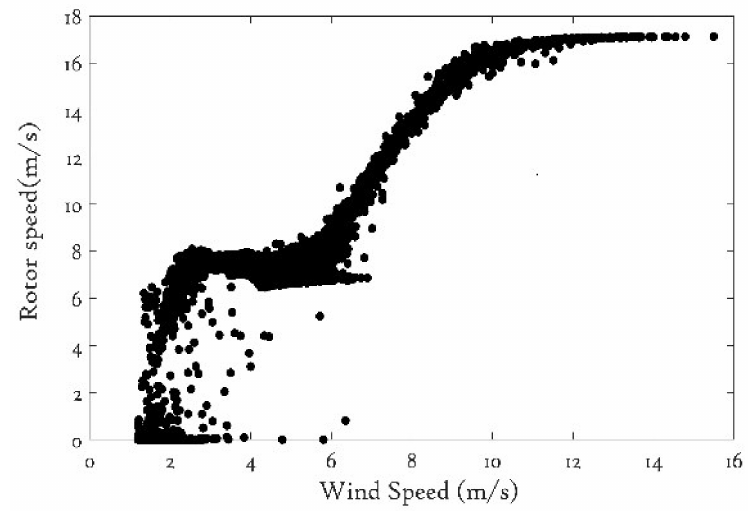
Figure 3. Measured Rotor speed